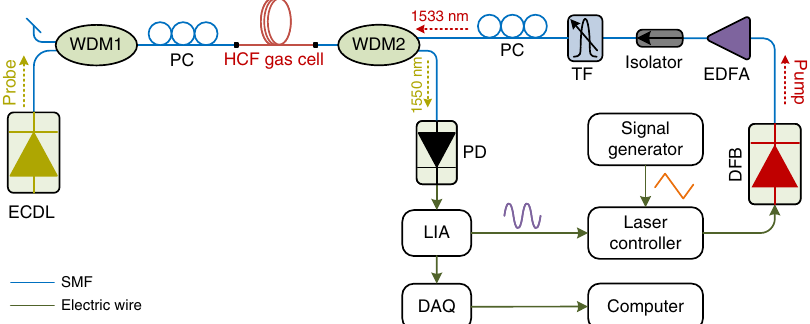
Fig. 3 Experimental setup. EDFA erbium-doped fi ber ampli fi er, TF tunable optical fi lter to minimize EDFA ’ s ampli fi ed spontaneous emission noise, WDM1 and WDM2 1550 nm/1530nm wavelength-division multiplexers, PC polarization controller, LIA lock-in ampli fi er, DAQ data acquisition card, DFB distributed feedback laser (the pump), ECDL external-cavity diode laser (the probe), PD